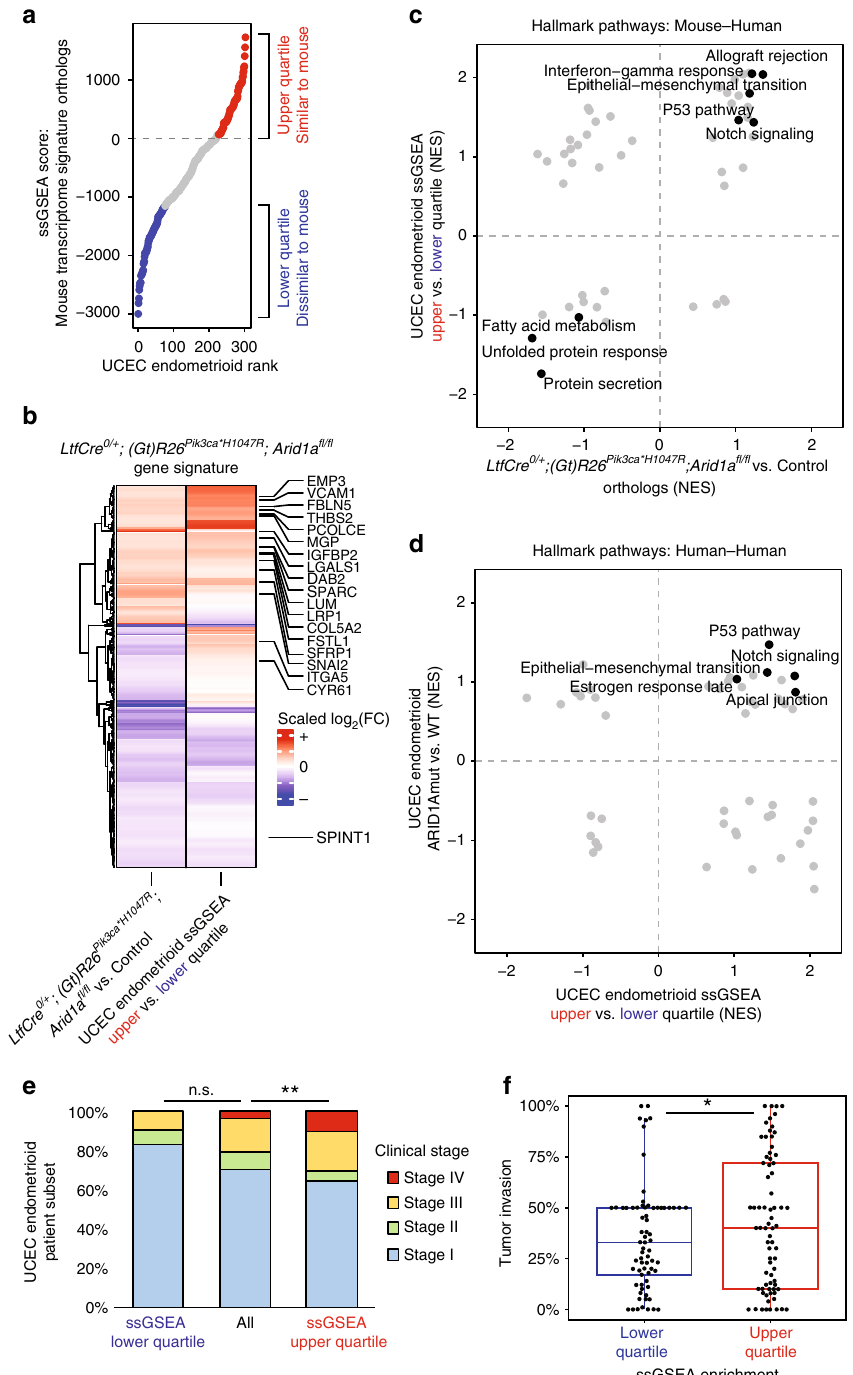
Fig. 3 LtfCre 0/ + ; (Gt)R26Pik3ca *H1047R ; Arid1a fl / fl gene signature correlates with invasive patient gene expression. a Distribution of TCGA-UCEC endometrioid patient tumors relative to ssGSEA score for human orthologs of LtfCre 0/ + ; (Gt)R26Pik3ca *H1047R ; Arid1a fl / fl gene signature. b Clustered comparison of scaled fold-change values for signature genes between LtfCre 0/ + ; (Gt)R26Pik3ca *H1047R ; Arid1a fl / fl vs. control mice and upper vs. lower quartile of UCEC endometrioid patients. EMT genes from Hallmark pathway and Mak and Tong pan-cancer gene signature are identi fi ed. c Scatter plot of Hallmark pathway GSEA Normalized Enrichment Scores (NES) from LtfCre 0/ + ; (Gt)R26Pik3ca *H1047R ; Arid1a fl / fl vs. control (human orthologs) and upper quartile of UCEC endometrioid patients vs. lower quartile. d Scatter plot of Hallmark pathway GSEA NES from upper quartile of UCEC endometrioid patients vs. lower quartile and UCEC endometrioid ARID1A mut (frameshift/truncating alterations) vs. ARID1A wt . e Upper quartile ssGSEA-enriched UCEC endometrioid patients present with higher stage disease relative to all patients ( p < 0.01, Chi-squared). f Upper quartile ssGSEA-enriched UCEC endometrioid patients have more invasive tumors relative to lower quartile patients ( p < 0.05, unpaired Mann – Whitney U , one-tailed). Box-and-whiskers plotted in the style of Tukey without